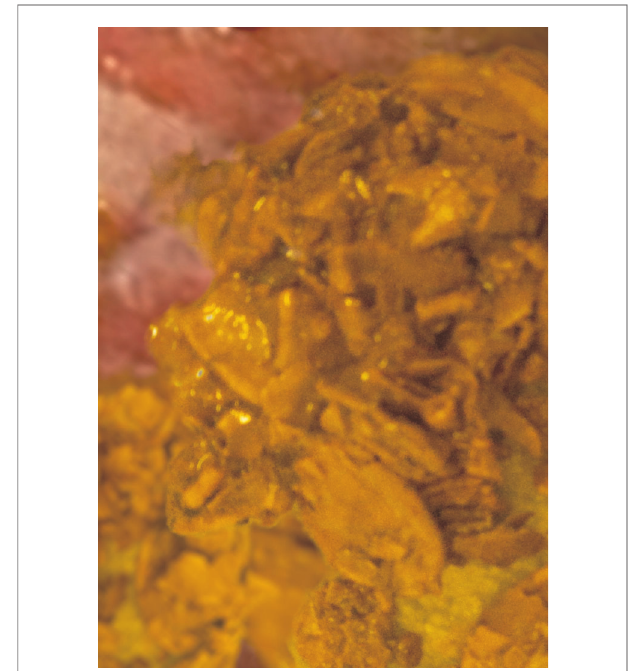
FIGURE 2 | Bezoar in the